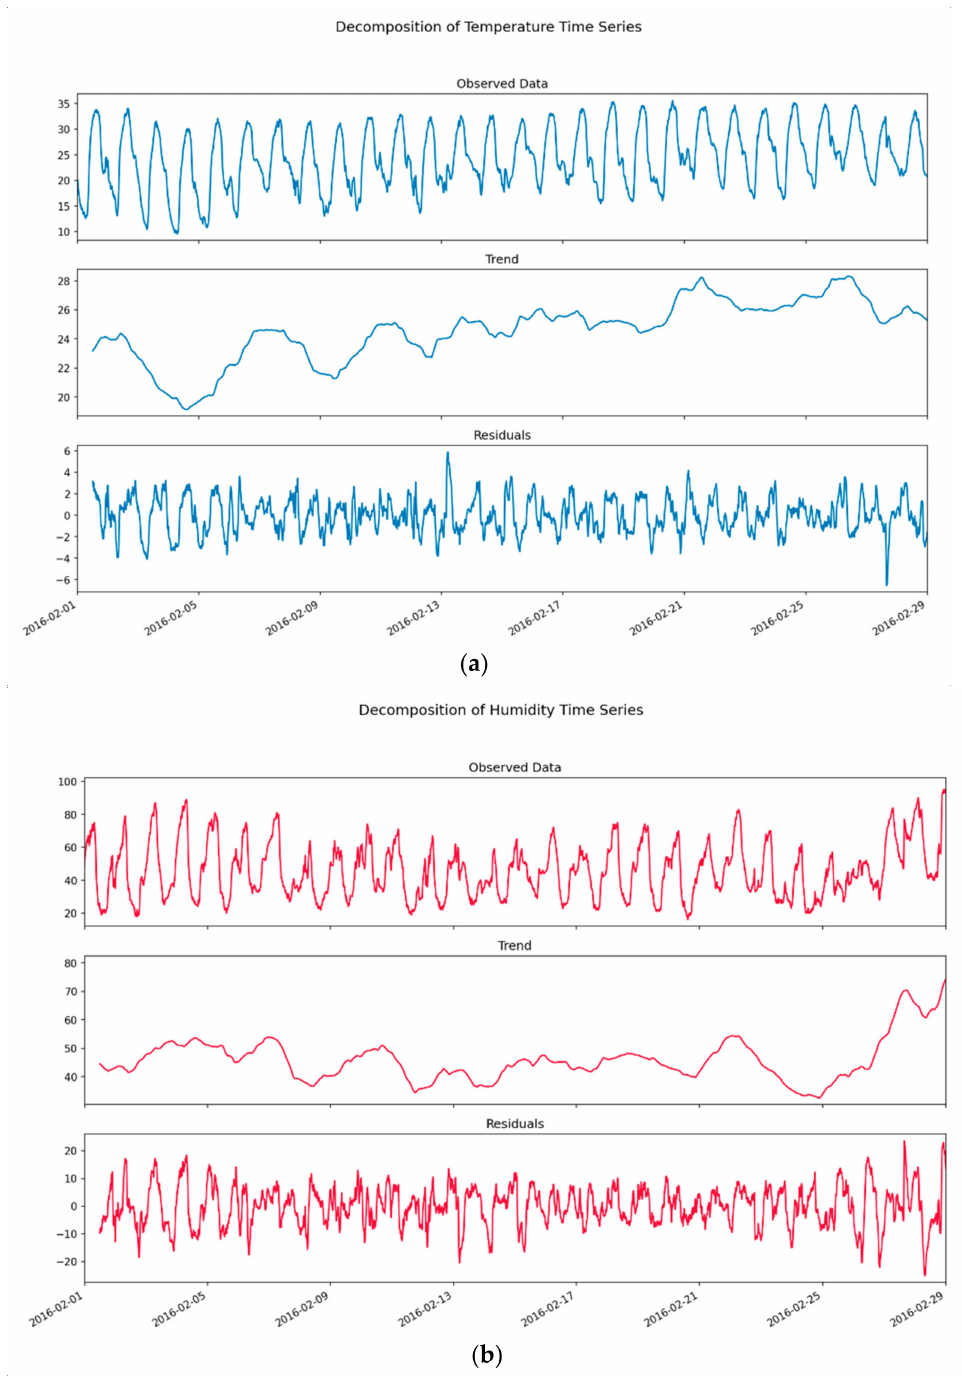
Figure 4. Seasonal and Trend Decomposition with Loess (STL) decomposition of timeseries datasets ( a ) Decomposed Temperature Time Series ( b ) Decomposed Humidity Time